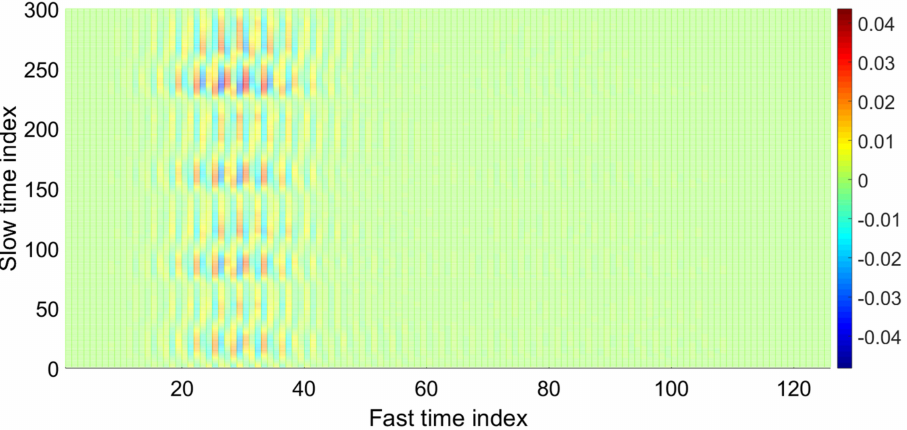
Figure 3. Waveforms after clutter removal.